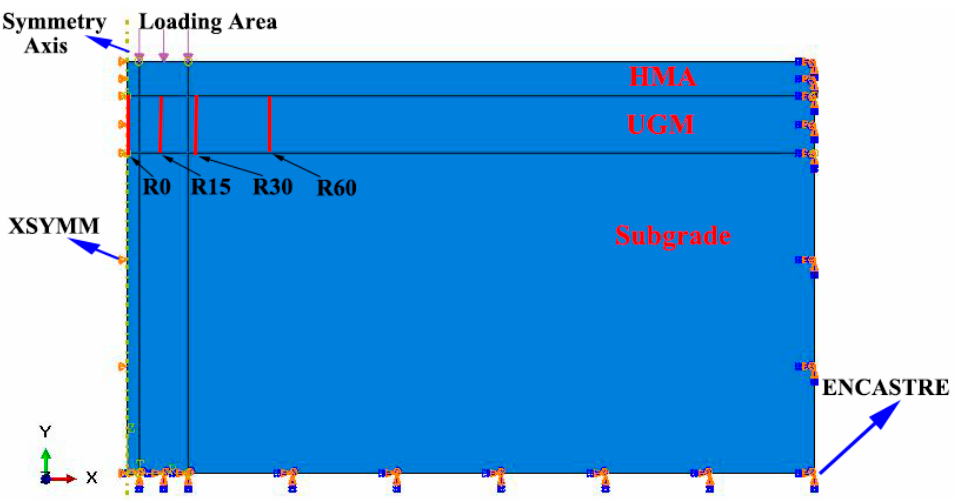
Figure 3. 2-Dimensional model of pavement structure.